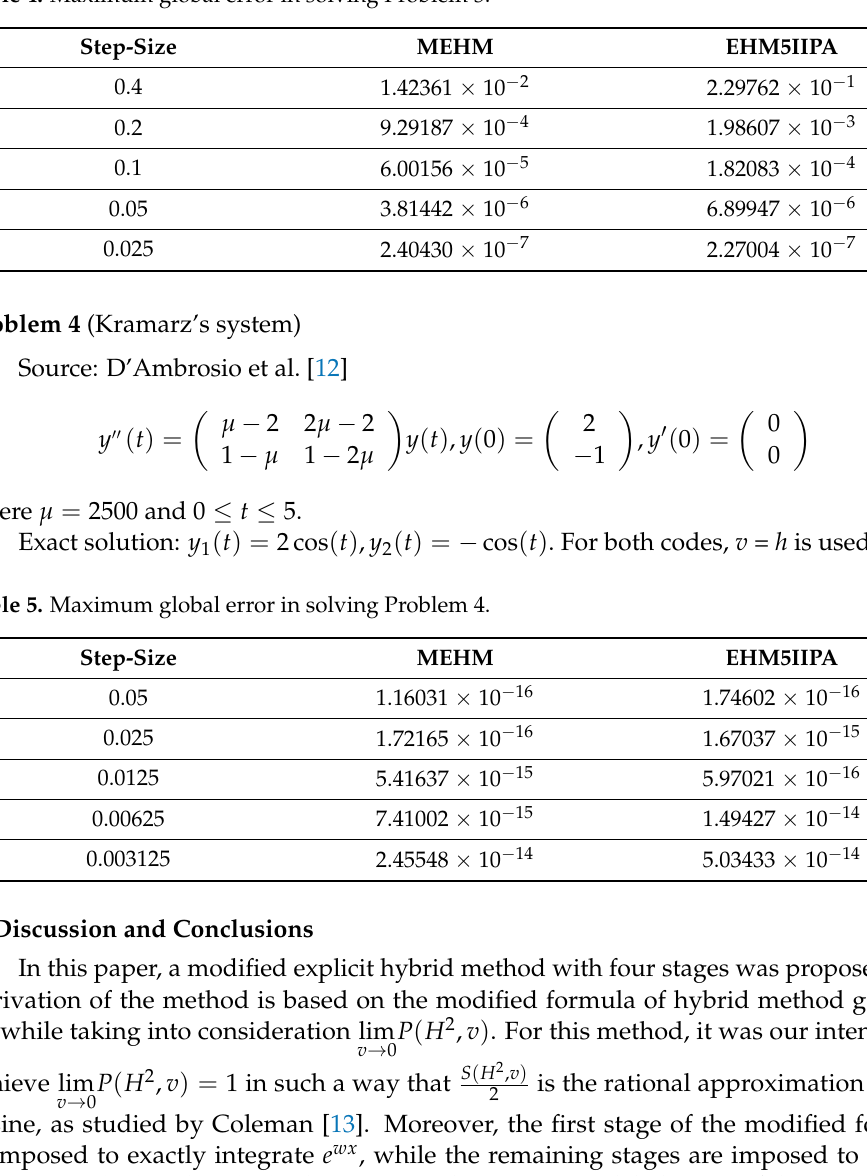
Table 4. Maximum global error in solving Problem 3.